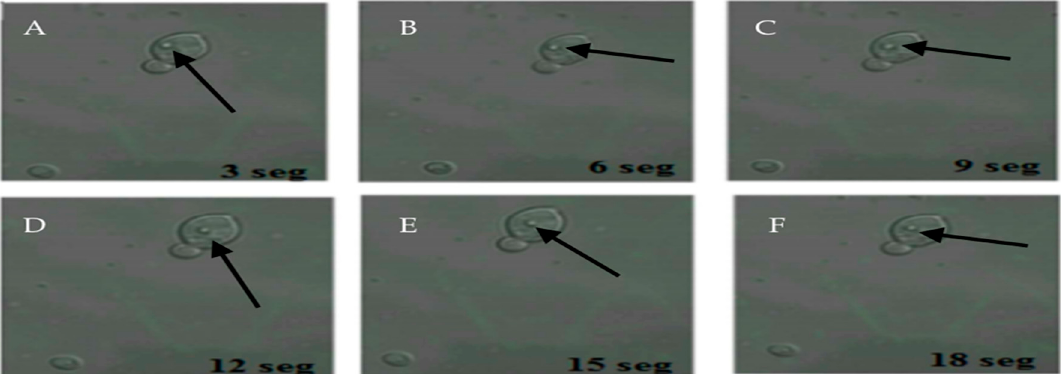
Figure 3. Movement of H. pylori within yeasts of vaginal discharge origin. Confocal microscopy images taken 3 s apart using a Zeiss LSM780 NLO confocal microscope. ( A – F ) show the movement of H. pylori (arrows) inside the vacuole of a yeast cell. Light green color observed in the background represent remnants of fluorescein isothiocyanate (FITC). This figure is representative of images of one of the triplicates of one of the vaginal discharge samples positive for the presence of intra-yeast H. pylori.